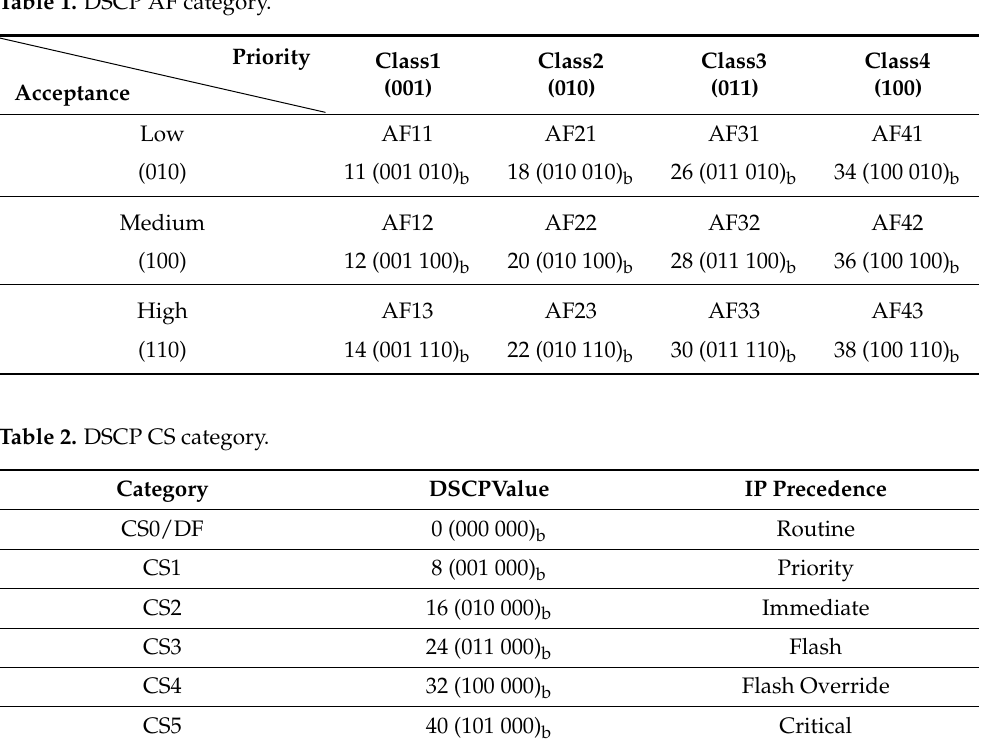
Table 1. DSCP AF category.